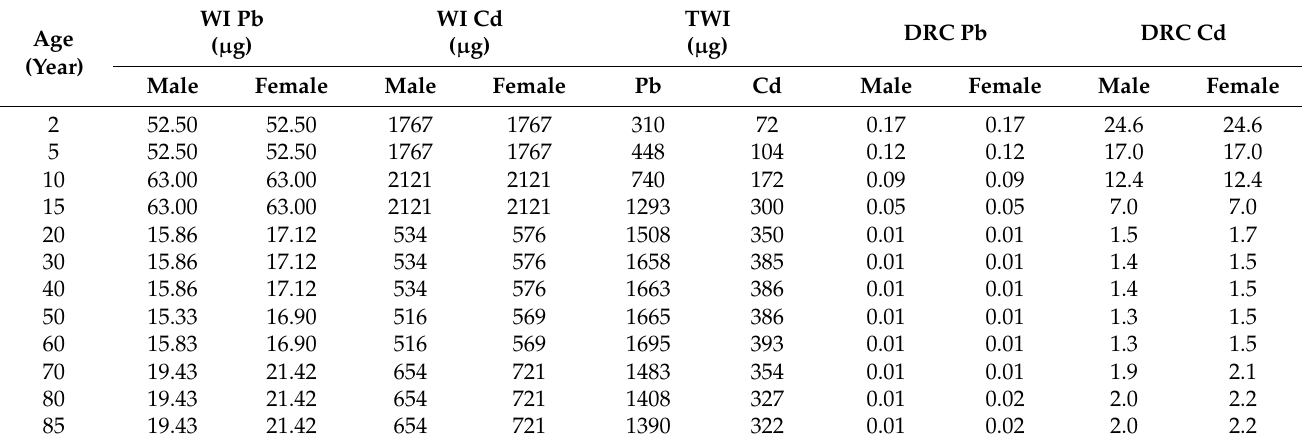
Table 5. Weekly intake and dietary risk to Pb and Cd from milk consumption in populations aged 2–85 years in Peru.